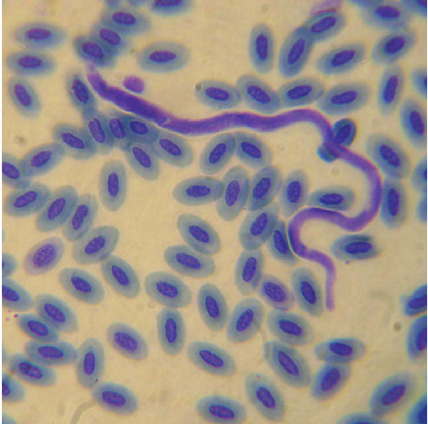
Figure 5: Microfilariae of genus